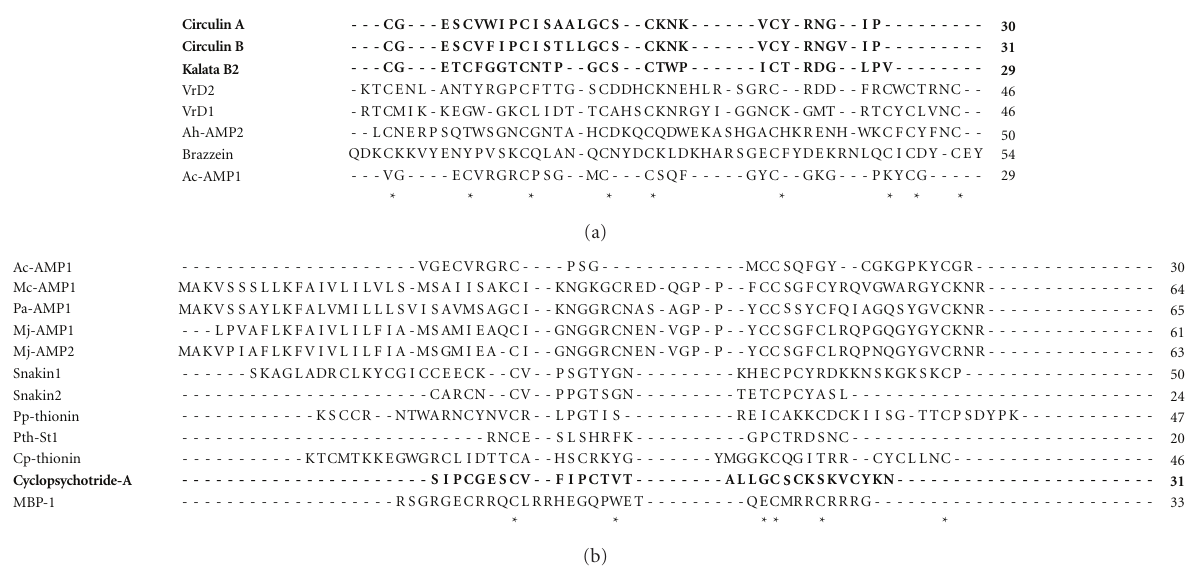
Figure 1: (a) Alignment of antibacterial peptides with defined three-dimensional structure: circulin A (1BH4); circulin B (2ERI); kalata B2 (1PT4); VrD1 (1BK8); VrD2 (2GL1); Ac-AMP2 (1MMC); brazzein (1BRZ). (b) Alignment of several antibacterial peptides from plant sources with sequences available at the Protein Data Bank. Hevein-like: Ac-AMP1 (AAB22103.1); knottin peptides: Mc-AMP1 (081338.1), Pa-AMP1 (P81418.1), Mj-AMP1 (P25403.4), Mj-AMP2 (P25404.2); snakins: snakin1 (AAD01518.1), snakin2 (ABL74292.1); defensins and thionins: pp-Thionin (P07504.1), Pth-St1 (AAB31351.1), and Cp-thionin (P84920.1); cyclotide: cyclopsychotride A (P56872.2); other peptides: MBP-1 (AAB23306.1). Asterisks show conserved cysteine residues. Sequences in bold represent peptides with cyclic three- dimensional conformations, indicating that they do not have N- and C-termini. Therefore, the alignment of cyclotides was based through comparison with the N- and C-termini of the other peptide